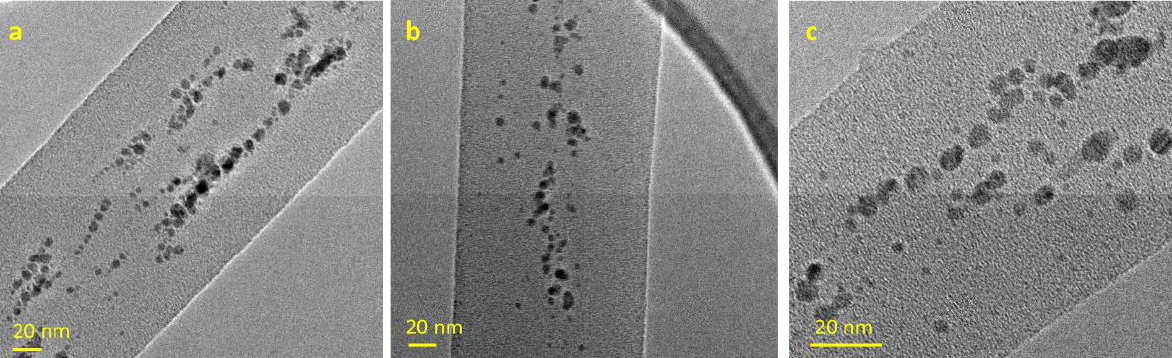
Figure 5. TEM images of PLA — AgNPs fibers, 7% ( w / w ) PLA in DCM/DMF, Ag/PLA 5.0 wt.%. ( a ) and ( b ) low magnification; ( c ) high magnification.